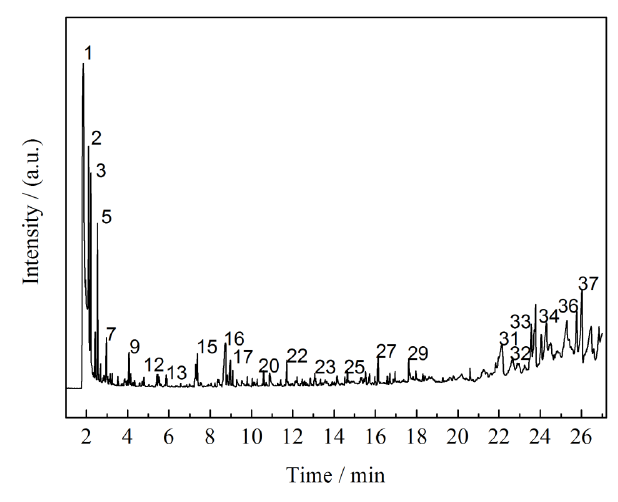
Figure 7. Pyrolysis products of FR-PVA/PAN at 537 °C. Table 6. Main products from fast pyrolysis of FR-PVA/PAN under air atmosphere (% in relative area). No.